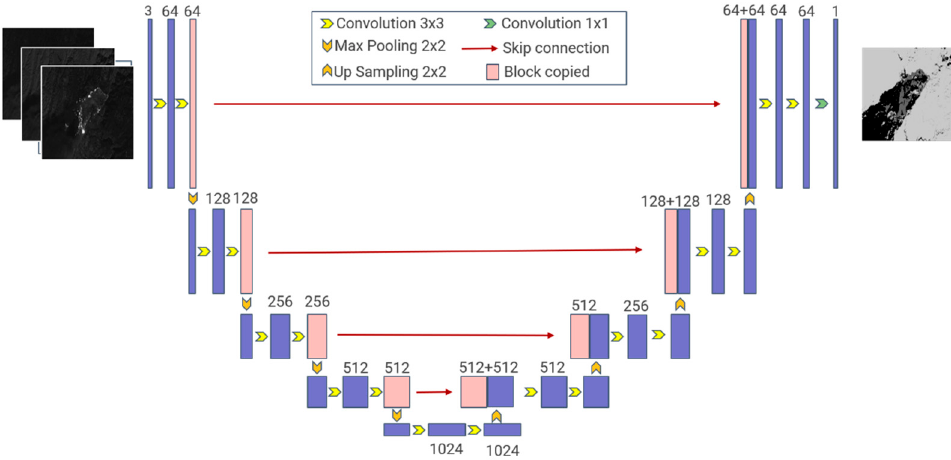
Figure 9. Schematic of the U-Net network structure with the vgg structure in the encoder section. Softmax cross entropy (CE) and Focal loss are chosen as the weighted functions in this paper. As the most used loss function in the classification, CE loss is based on the theory that cross entropy can be used to measure the difference between the probability distribution learned by the model and the true probability distribution. Focal loss modifies the CE loss function by adding a focusing factor γ to reduce the contribution of easily categorized samples in the loss calculation to solve the category imbalance problem. In this study, the focusing factor γ is a constant, γ = 3 .